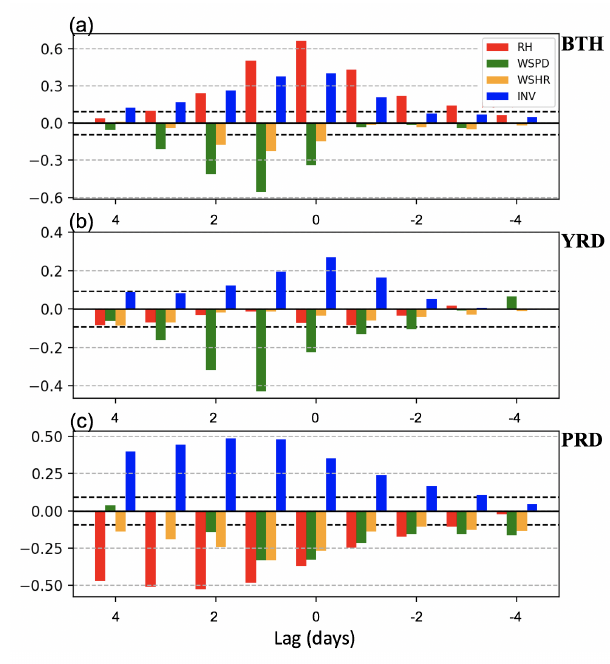
Figure 2. Lagged correlations between daily mean PM 2 . 5 concen- trations and regional meteorological variables including relative hu- midity (RH; red bars), wind speed (WSPD; green bars), vertical wind shear (WSHR; gold bars) and inversion intensity (INV; blue bars) over (a) BTH, (b) YRD and (c) PRD during DJF 2013–2017. Horizontal dashed black lines indicate the 95% confidence level us- ing the two-tailed Student’s t